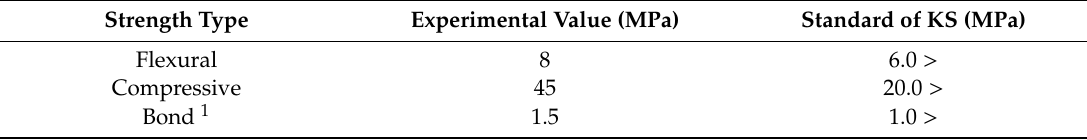
Table 4. Detailed specifications of the polymer mortar provided by the